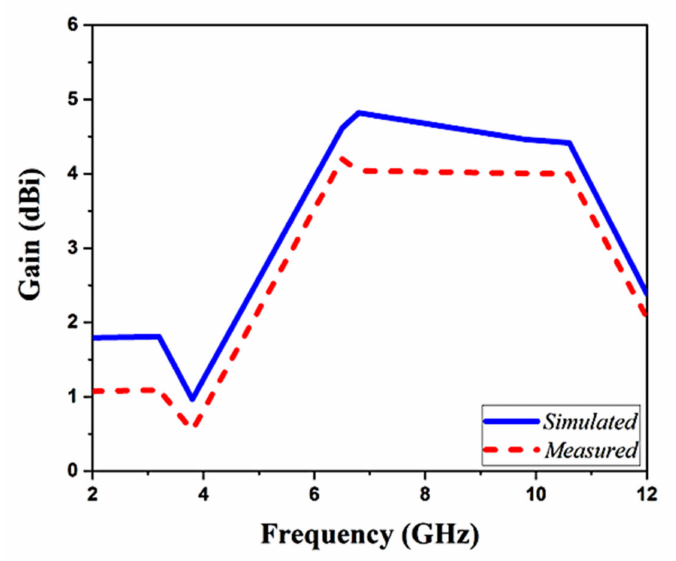
Figure 15. Simulated and measured gain for the designed Sierpinski hexagonal-shaped fractal